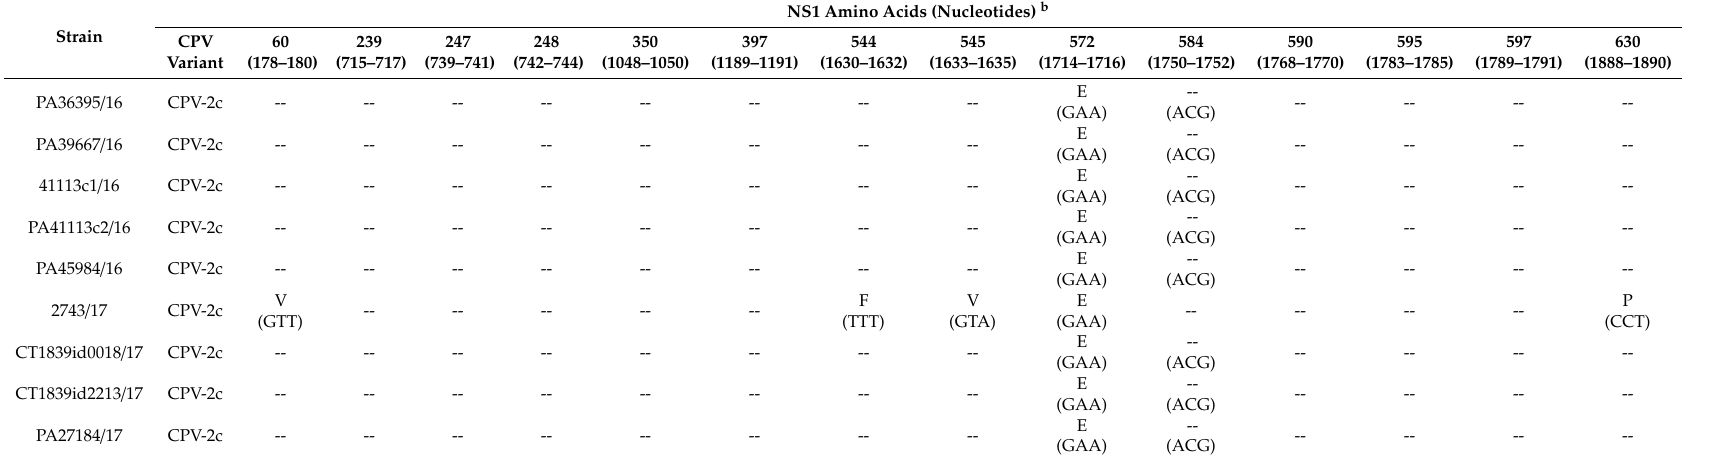
Table 4. NS1 non-synonymous changes of analyzed CPV strains described in this